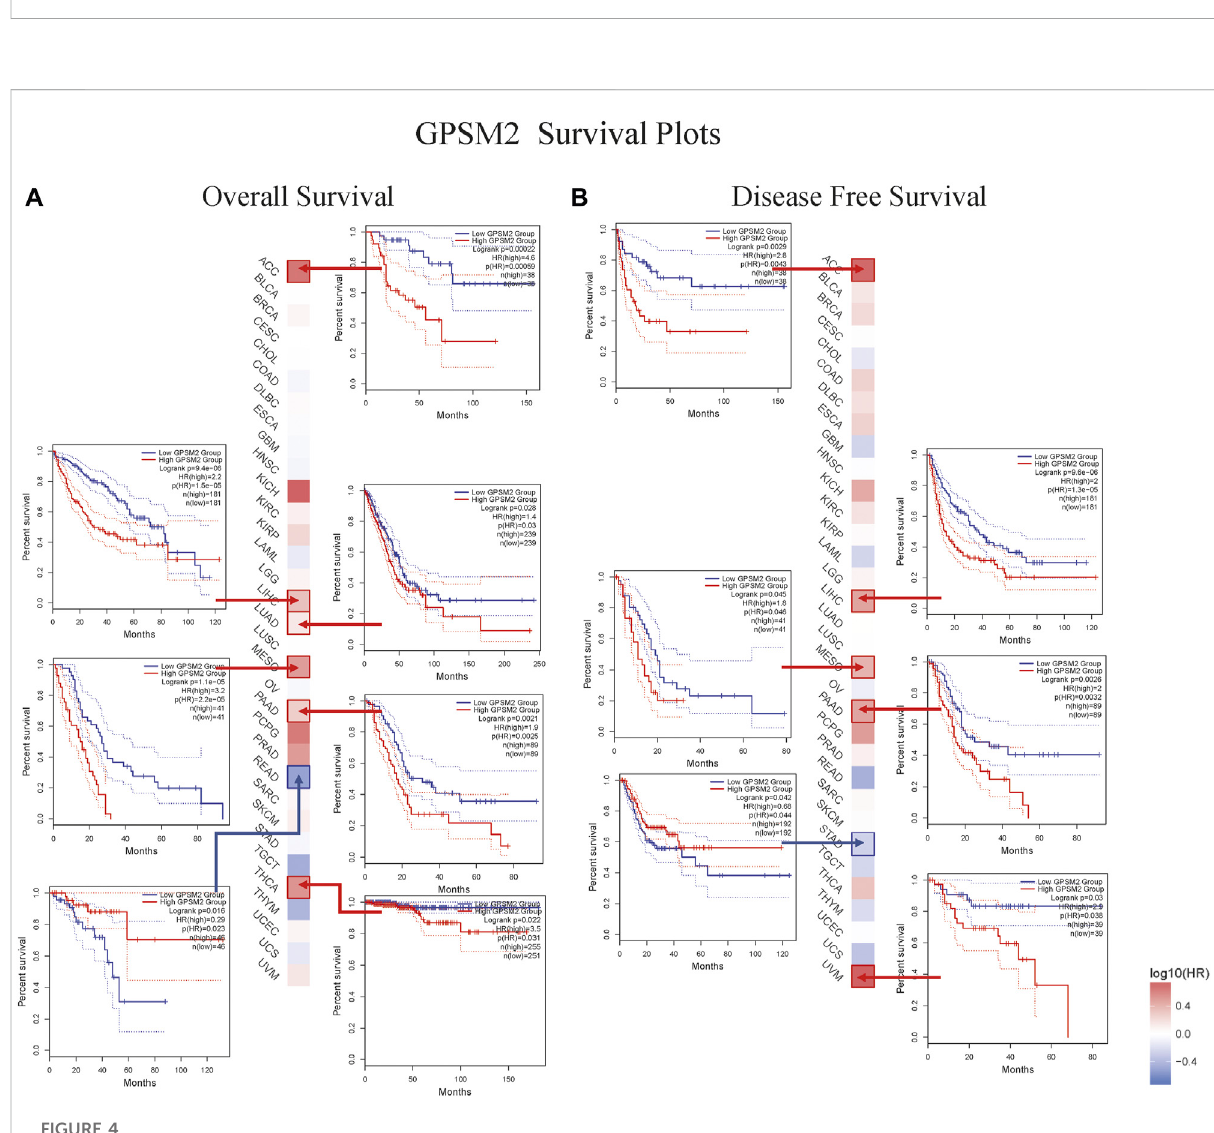
FIGURE 4 Prognostic survival map and Kaplan – Meier curve of GPSM2 expression in TCGA pan-cancer patients. (A) The relationship between GPSM2 expression and OS. (B) The relationship between GPSM2 expression and